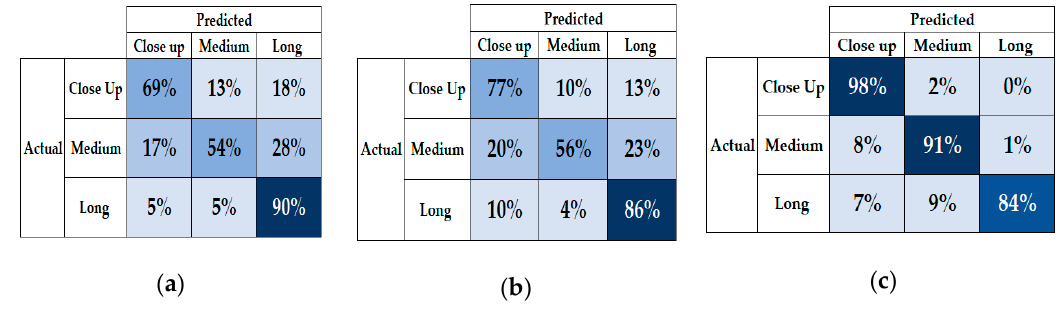
Figure 3. Comparison of shot scale classification [1]: ( a ) AlexNet; ( b ) GoogLeNet; ( c ) VGG-16.